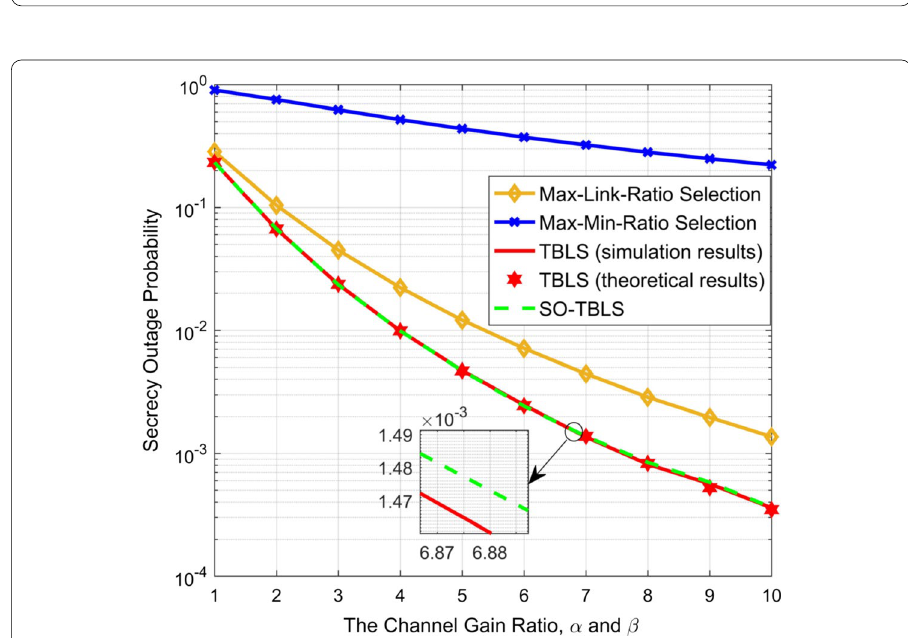
Fig. 9 The secrecy outage probability versus the channel gain ratio for different relaying